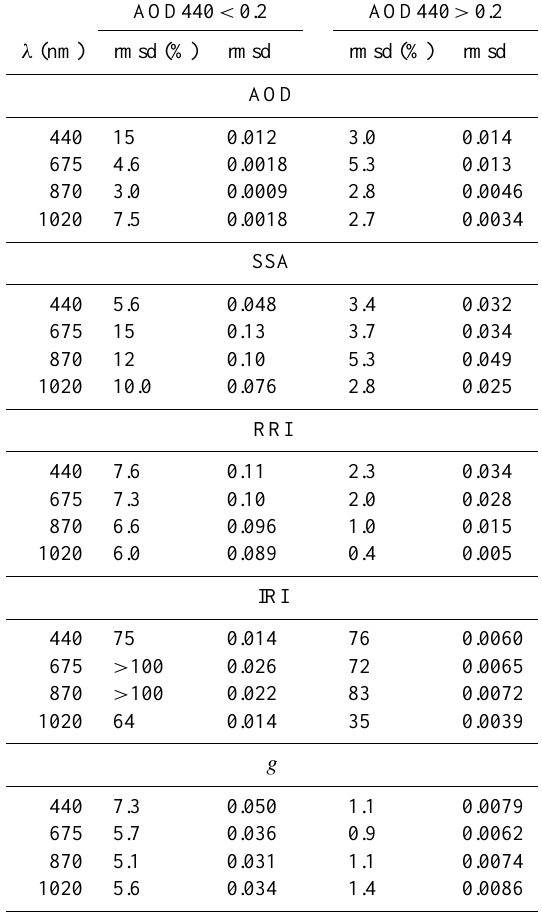
Table 2. Statistics of the differences between AERONET and SKYRAD properties separated by the AOD level.